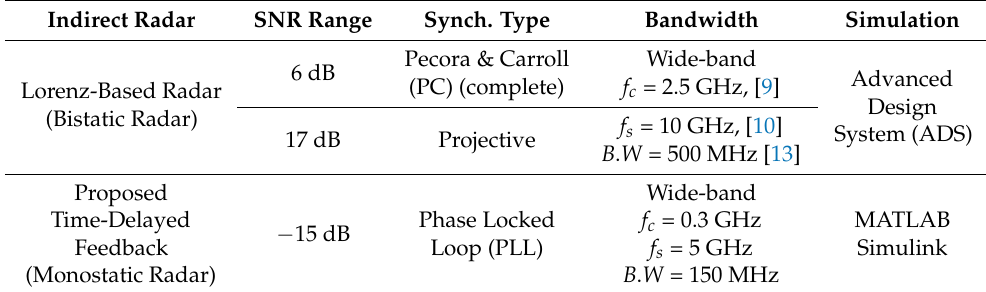
Table 2. A comparison of indirect FM Chaotic Radars when a time-delay feedback radar with echo delay = 2